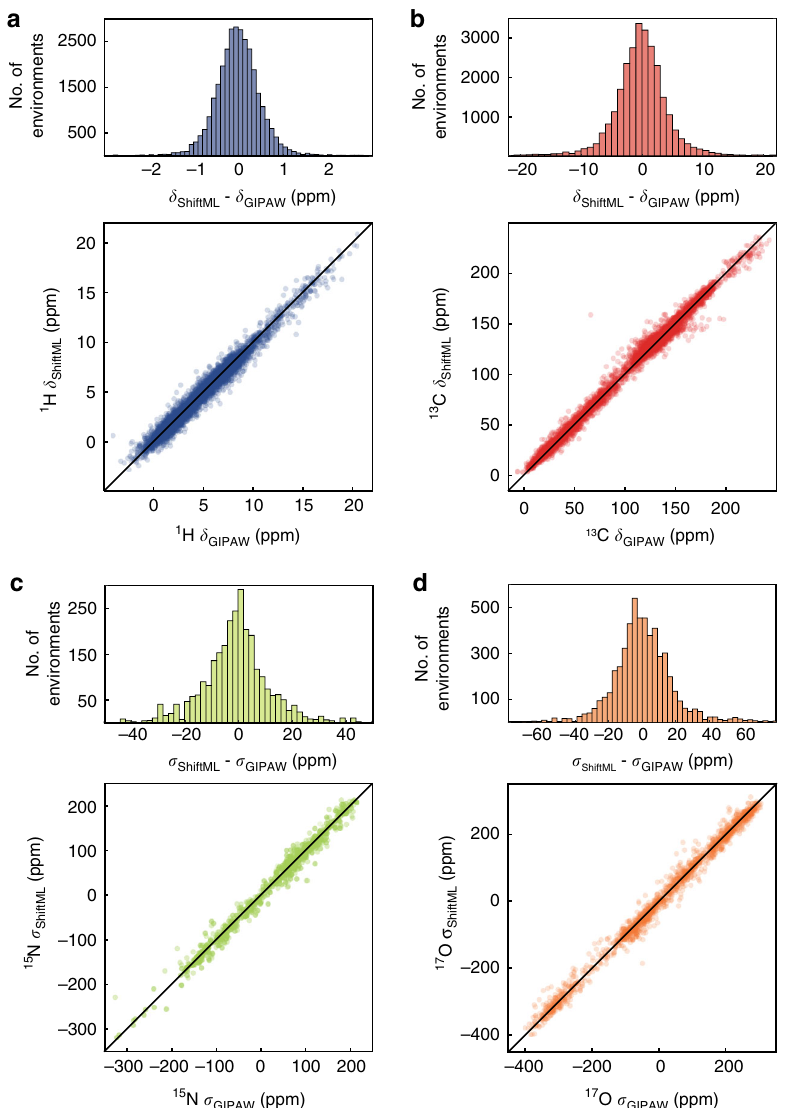
Fig. 3 Comparison of predictions from ShiftML and GIPAW DFT. Histograms and scatterplots showing the correlation between 1 H ( a ), 13 C ( b ), 15 N ( c ), and 17 O ( d ) chemical shifts (shieldings) calculated with GIPAW and ShiftML. The black lines indicate a perfect